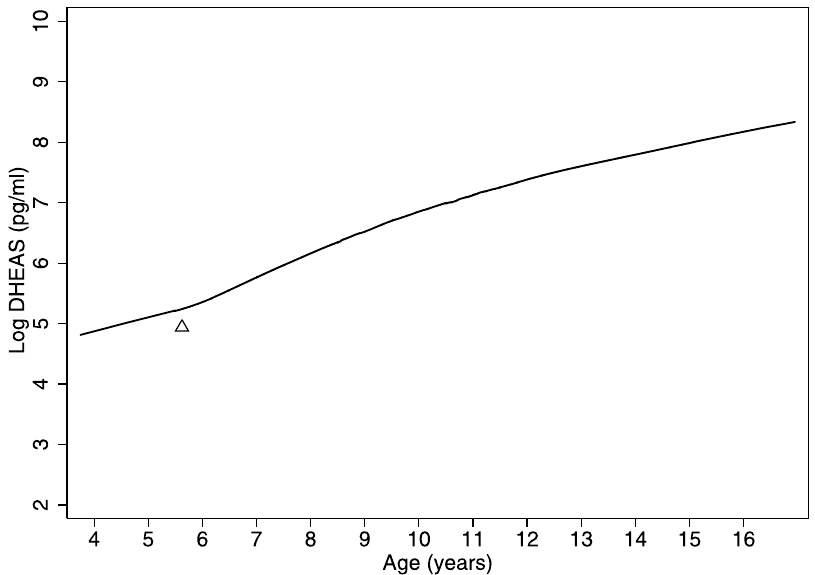
Figure 2. Lowess smoother of the log of DHEAS by age among all girls Aged 5–16 years. Triangle shows inflection point where log salivary DHEAS reaches 5.5–6 pg/ml, signifying the clinical threshold for adrenarche.